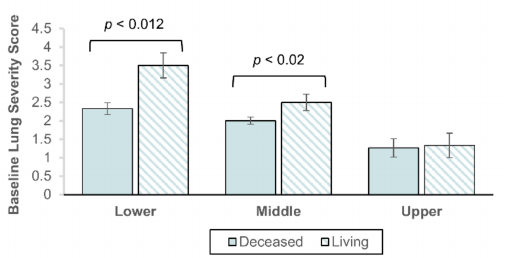
Figure 5. Mean lung severity score before prone ventilation by patient living status 28 days post-admission. Lung severity score measured by 3 experienced radiologists in chest X-rays captured the day before prone ventilation. Shown by lower, middle, and upper lung zones, summed for the left and right lung. Error bars represent S.E. of the mean. Statistical significance is given by the Mann-Whitney U test with α = 0.05.